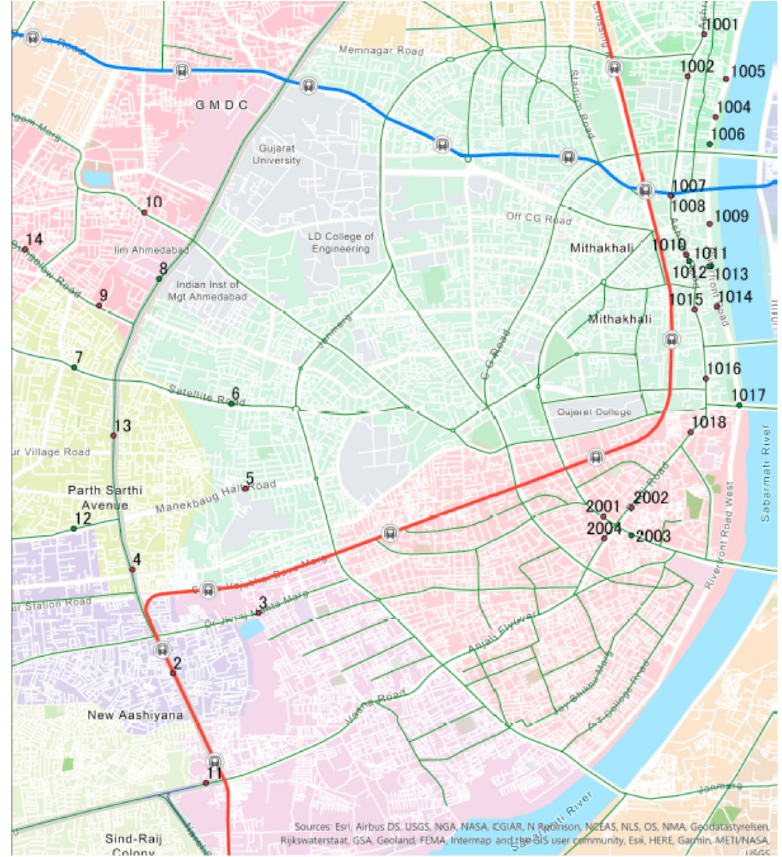
Figure 4. Traffic measurement environment in Ahmedabad city (the number is defined each CCTV installed location. Blue line and red line are the Metro line which is under development).